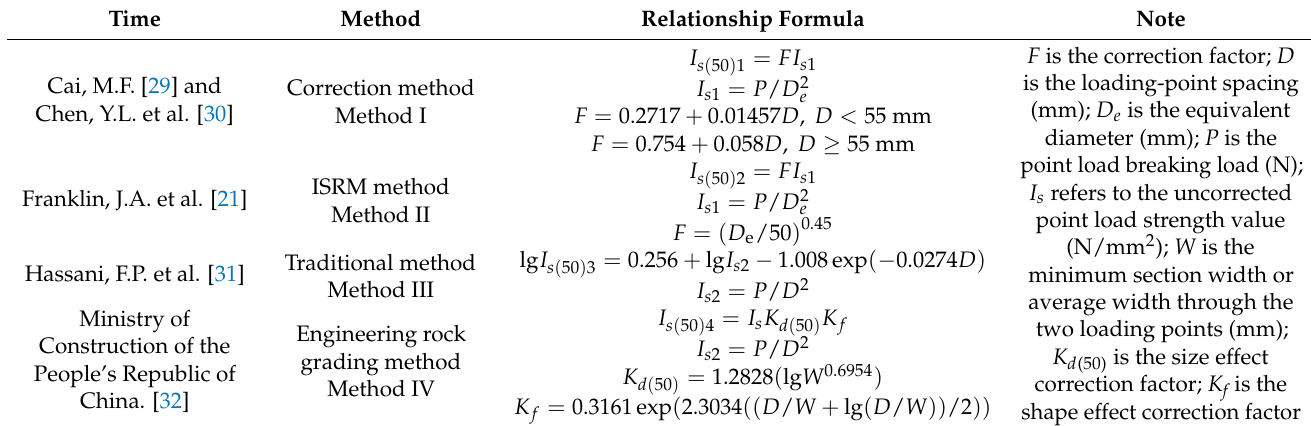
Table 4. Method of solving the standard point load